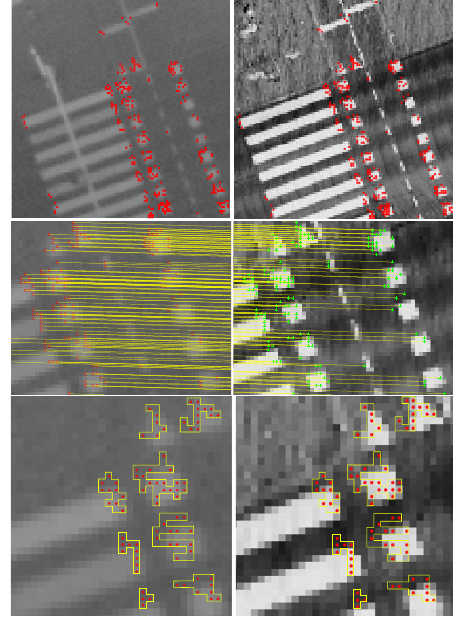
Figure 16. Different visualizations of the feature matching with developed method. 1